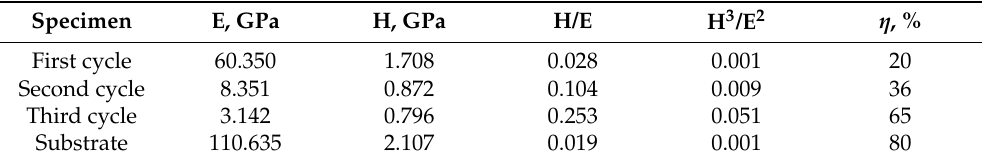
Figure 6. ( a )Young’s modulus and ( b ) hardness of the Ti substrate and the Ti-Ta coatings formed after each cycle. Table 2. Mechanical characteristics of the Ti-Ta coatings obtained after each cycle.